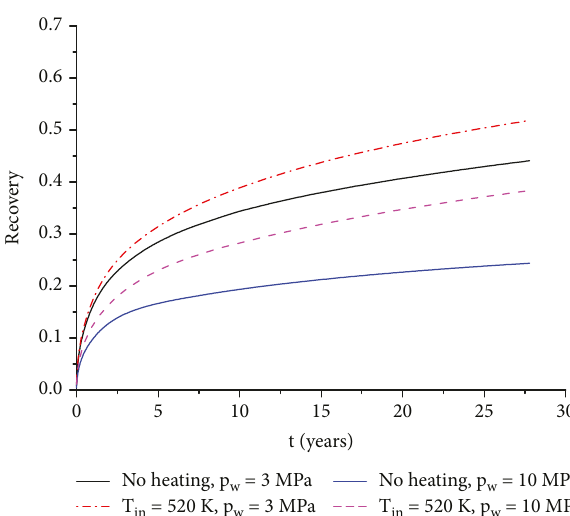
Figure 16: E ff ect of production pressure on thermal